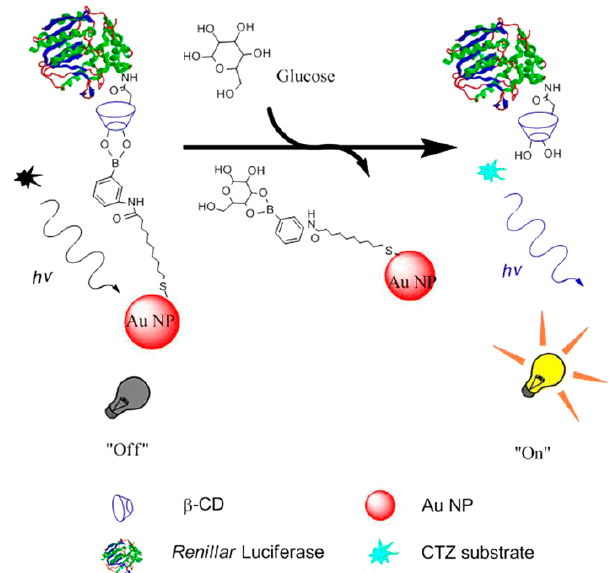
Figure 2. Schematic illustration of bioluminescence quenching-based nanosensor in glucose sensing. Reprinted with permission from [24]. Copyright Springer Nature 2017.